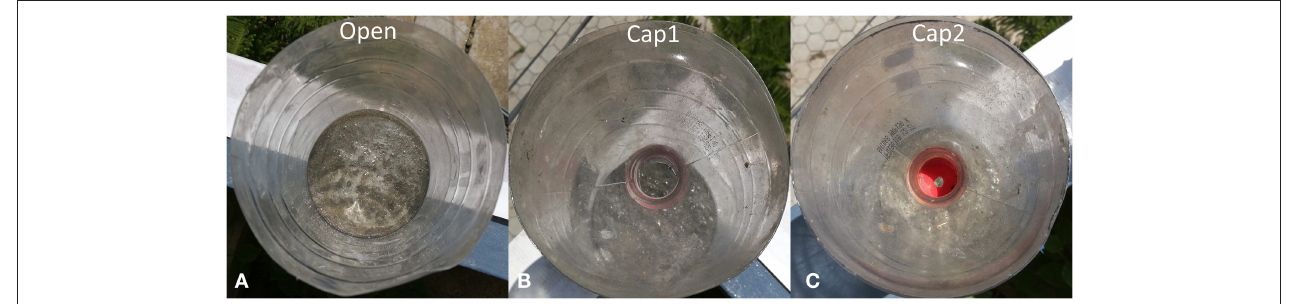
FIGURE 3 | Three different rain gauge cover configurations for evaporation measurements. Open (A) is completely open to the atmosphere. Cap1 (B) has the original top of the bottle inverted and placed back on top of the gauge. Cap2 (C) has the same cover but also includes the original soda bottle cap with a 7mm punched or drilled hole in the center to allow precipitation to enter the gauge. The resulting areas open to evaporation were roughly 7,850, 530, and 40 mm 2 for Open, Cap1, and Cap2 covers, respectively. The diameters of the cover and the lower portion of the gauge are the same, but the thickness of the plastic material causes a tight connection between the cover and the